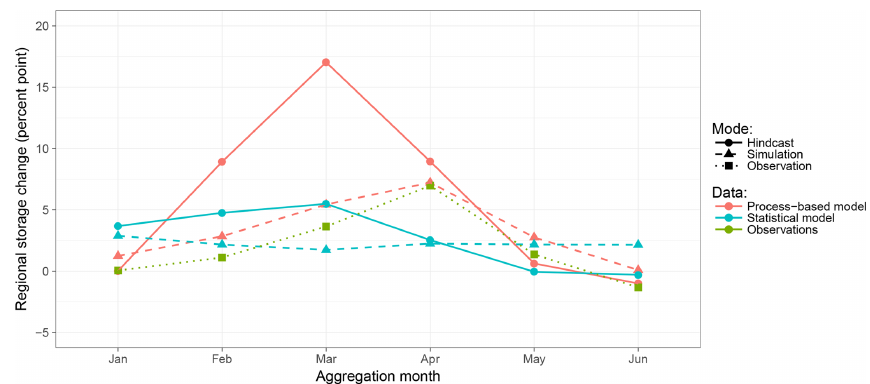
Figure 11. Monthly changes of regional reservoir storage averaged over all regions, years, and hindcast members for the two models and application modes in comparison to observations.